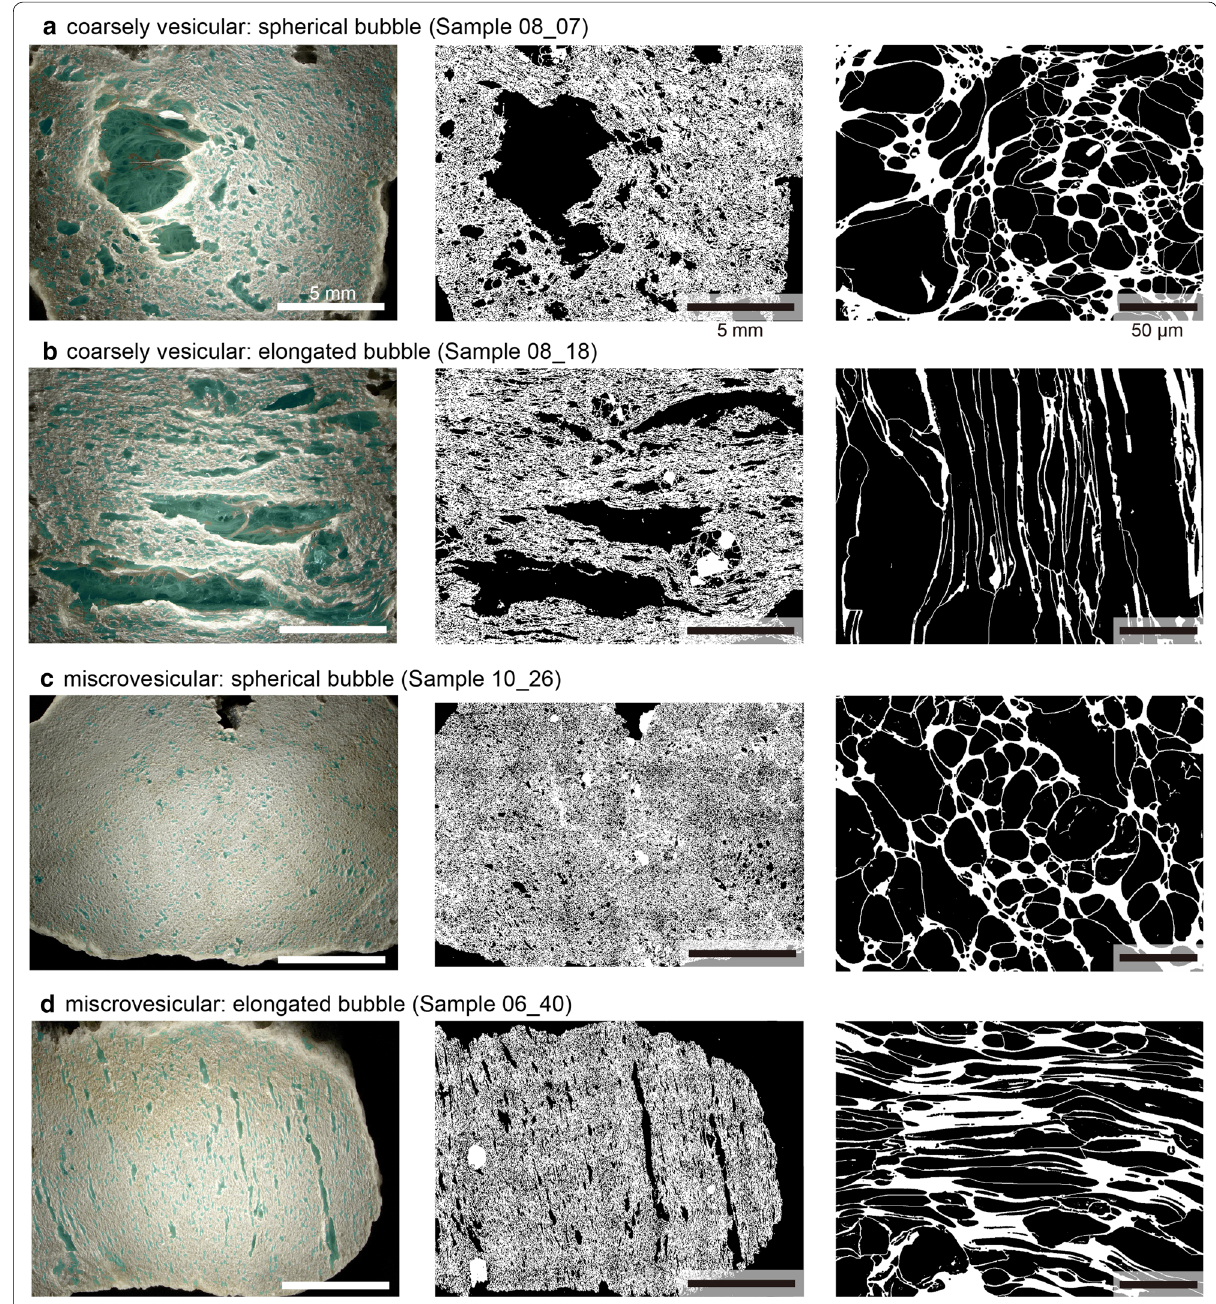
Fig. 4 Representative pumice samples form unit 5a (Taupo plinian fall deposit). Images of the representative samples (Table 2). The left column is the binary images of the DSM-LaRI like the one in Fig. 3c. The middle and right are the SEM images with bubbles appearing black. The scale is common within each